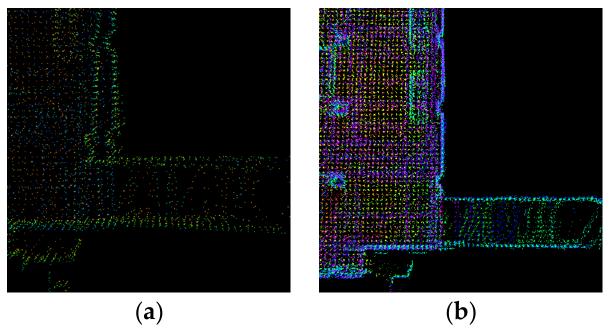
Figure 10. Partial enlarged view of the red boxed section in Figure 8: ( a ) for LeGO-LOAM; and ( b ) for LeGO-LOAM-SM.